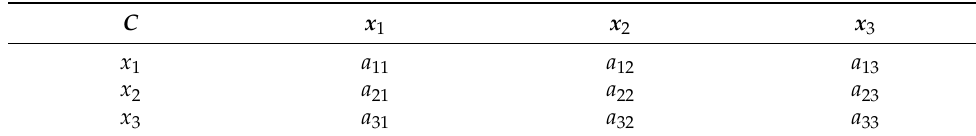
Table 3. Comparison matrix C.